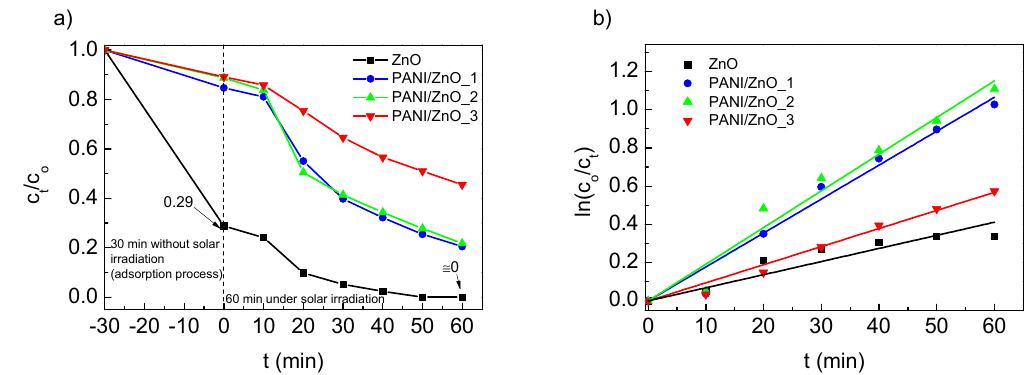
Figure 7. AB 25 photodegradation under solar irradiation treatment. ( a ) AB 25 photodegradation data and ( b ) linear plots of ln( c 0 / c t ) vs. irradiation time ( c 0 / c t data were normalized) obtained by using PANI / ZnO photocatalysts (pH = 7; cat = 1 g / L, AB 25 = 30 mg / L).